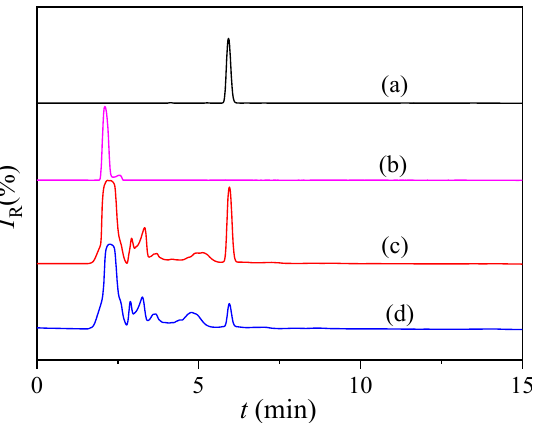
Figure 10. The chromatogram obtained after MIPs/NIPs-SPE pre-concentration of urine samples spiked with 10 μg∙mL − 1 of CAP and CYT, respectively. (a) CAP standard solution, (b) CYT standard solution, (c) solution after MIPs-SPE treatment and (d) solution after NIPs-SPE treatment. Chromatographic conditions include C18 reversed-phase column: mobile phase, acetonitrile-H 2 O (35/65, v/v ); flow rate, 0.5 mL∙min − 1 ; UV detector wavelength, 310 nm; column temperature, 30 °C.